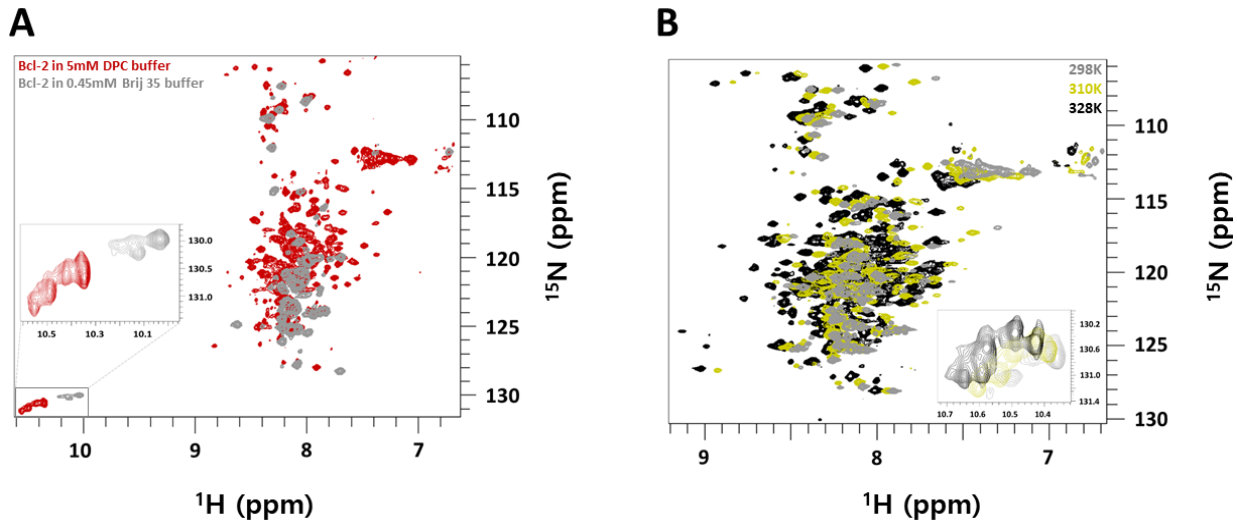
Figure 1. ( A ) Overlay of 1 H- 15 N-TROSY-HSQC NMR spectra of 0.3 mM 13 C/ 15 N/ 2 H-labeled Bcl-2 in 5 mM DPC micelles (red) in NMR buffer (20 mM NaPi, 20 mM NaCl, 2 mM TCEP at pH 6.0) and 0.35 mM 15 N-labeled Bcl-2 in 0.45 mM Brij-35 micelles in NMR buffer at pH 7.4 (gray). All spectra were acquired at 298 K. ( B ) Overlay of 1 H- 15 N-TROSY-HSQC NMR spectra of 0.36 mM 15 N-labeled Bcl-2 at 298 K (gray), 310K (olive yellow), and 328 K (black) in 5 mM DPC micelles in NMR buffer. Zoomed box shows the tryptophan side-chain region of the spectra.